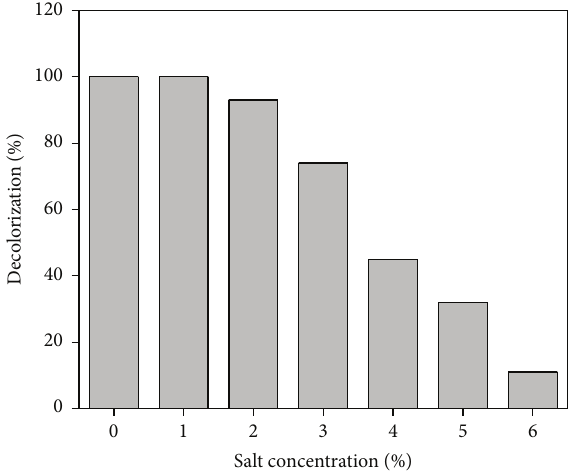
Figure 6: Effect of initial dye concentration on decolorization of Reactive Violet 5.